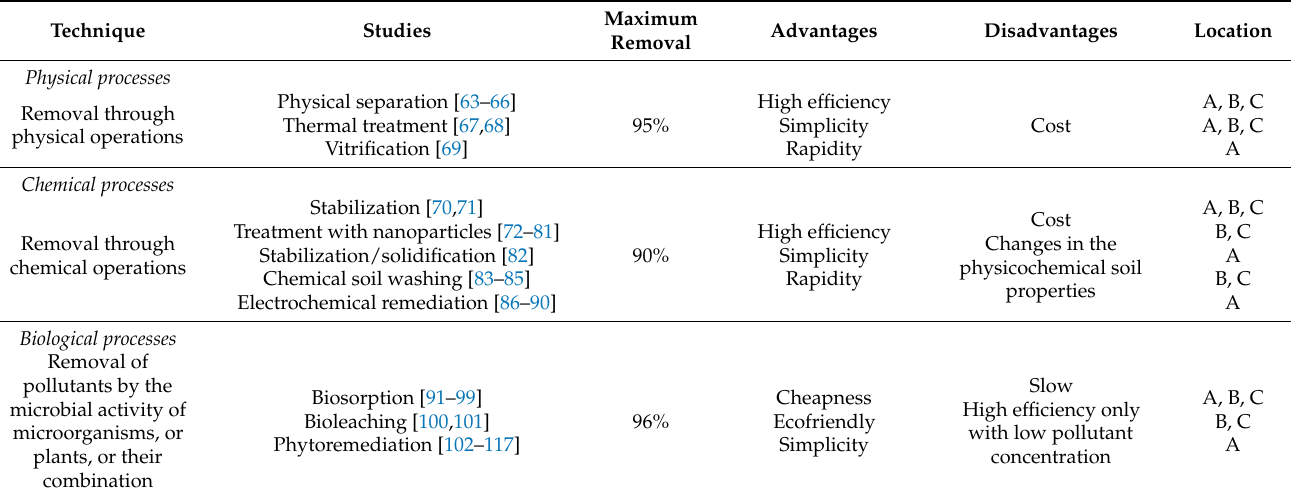
Table 4 reports a summary of the techniques and their main characteristics. Table 4. Removal techniques for heavy metals/metalloids.